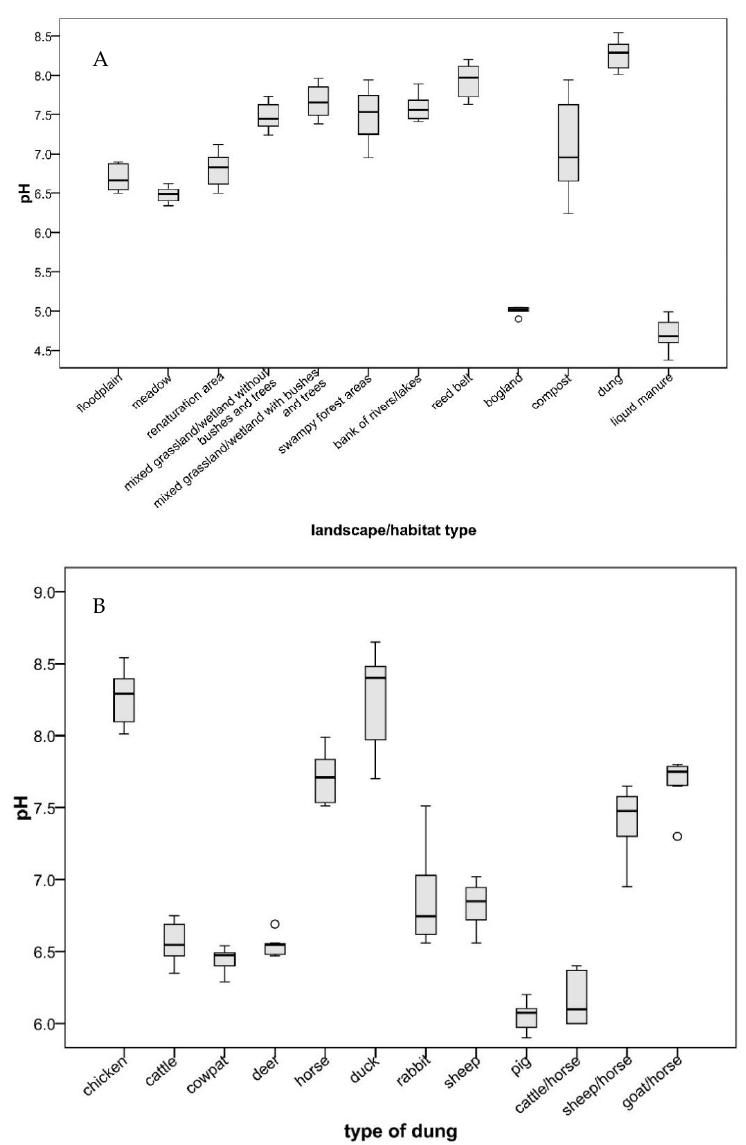
Figure 3. Box plots of pH values of the studied landscape/habitat types ( A ) and the types of dung ( B ), showing median, 25th and 75th percentiles and minimum and maximum values. Circles indicate outliers.